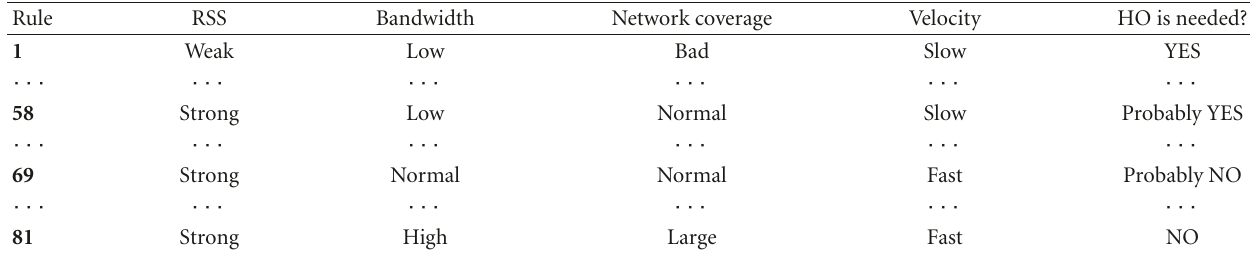
Table 1: Examples of fuzzy